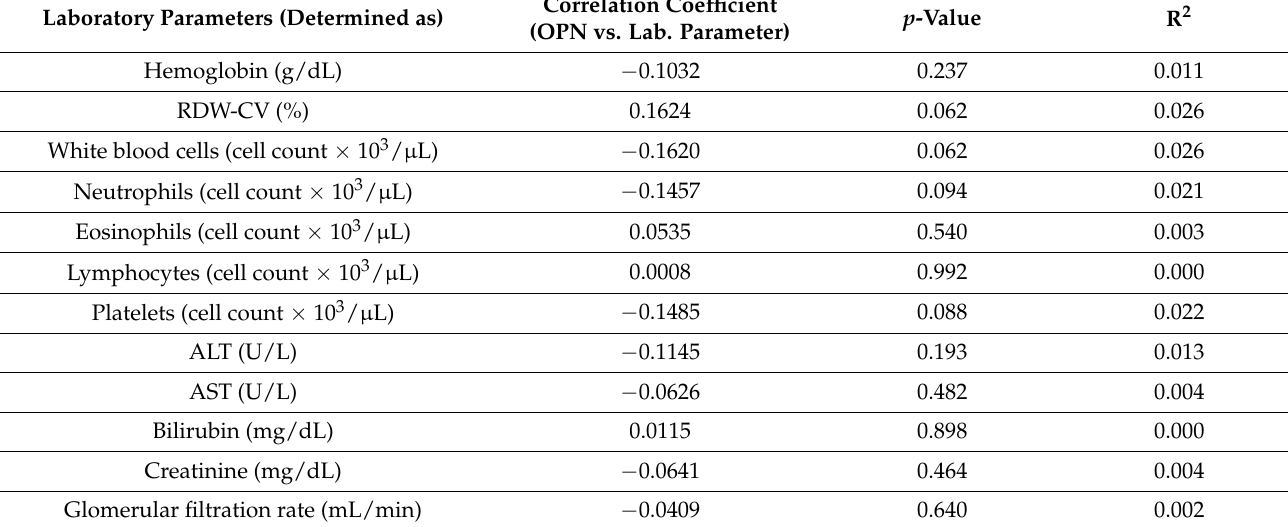
Table 5. Multiple correlation analyses between laboratory parameters related to clinical severity or inflammation status and OPN levels (ng/mL) measured at hospital admission (baseline t0). Statistically significant results are evidenced in bold